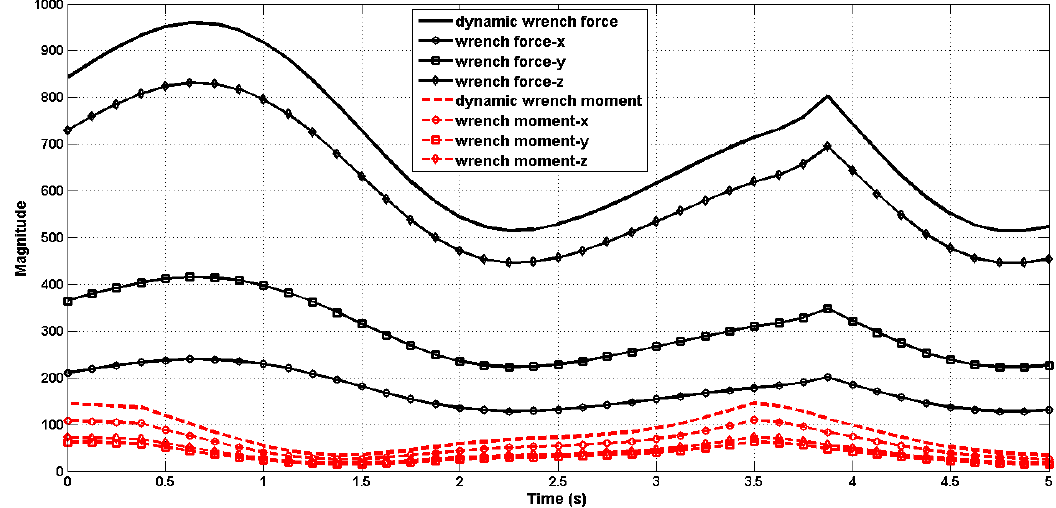
Figure 9. Variations of dynamic wrenches along prescribed trajectory for [ η 1 ,. . ., η 6 ] = [0.2038, 1.0000, 0.0000, 1.0000, 0.4576, 1.0000].